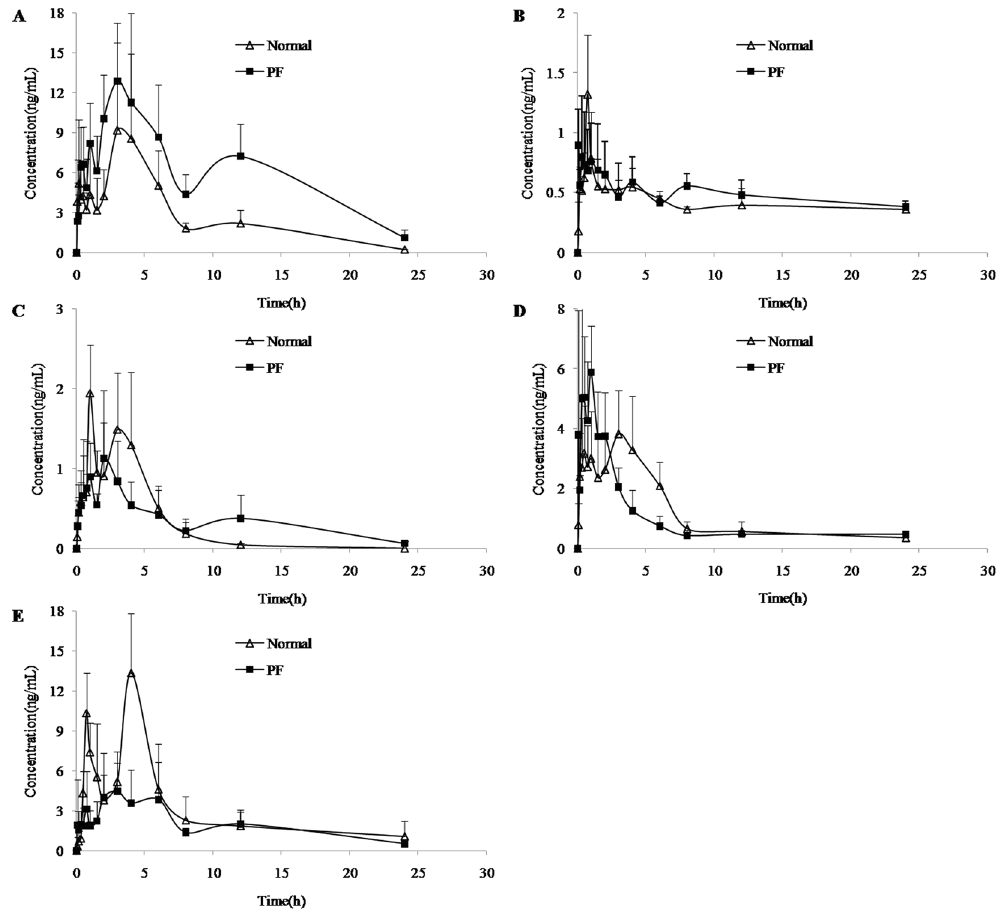
Figure 8. The concentration–time curves of calycosin ( A ), calycosin-7-O-glucoside ( B ), formononetin ( C ), ononin ( D ) and mangiferin ( E ) in rat plasma after the oral administration of PRM in normal and PF groups (n = 6).